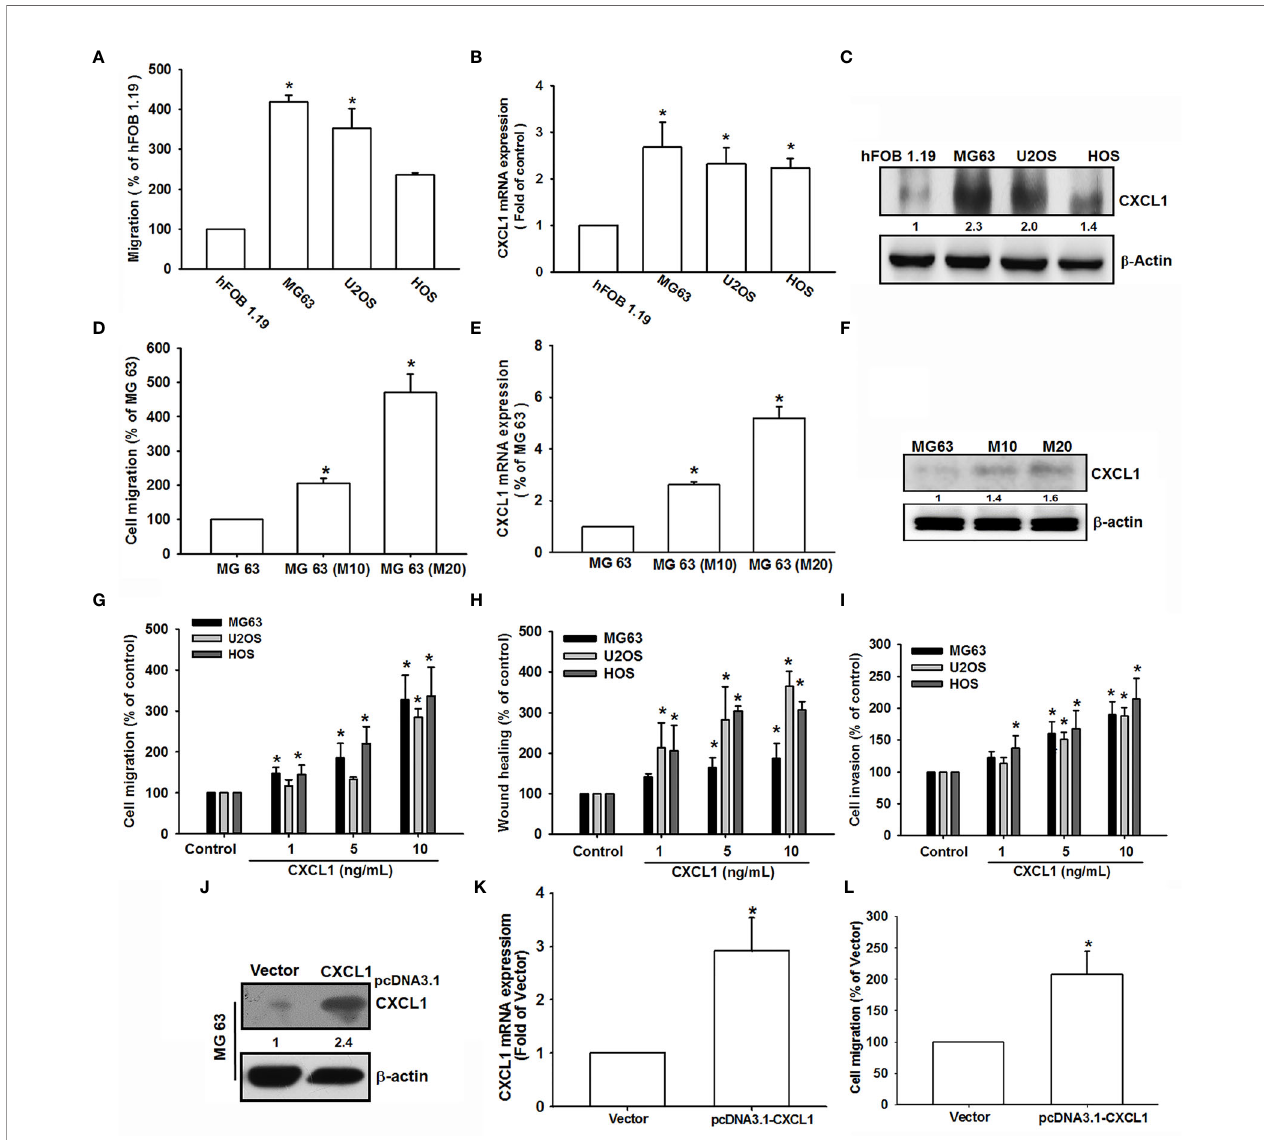
FIGURE 1 | CXCL1 increased migration, invasion, and wound healing in human osteosarcoma MG63, U2OS, and HOS cells. (A) The cell migration ability of the osteoblast cell line hFOB 1.19 and the osteosarcoma cell lines MG63, U2OS, and HOS was assessed using the Transwell assay. (B, C) Total mRNA and protein were collected from the indicated cell lines, and CXCL1 expression was detected using qPCR and Western blotting. (D – F) Migratory ability and CXCL1 expression of the indicated cells (MG63, M10, and M20) were examined by Transwell, qPCR, and immunoblotting assays. (G – I) Cells were incubated with CXCL1 (1 – 10 ng/ml) and the Transwell assay were used for detecting in vitro migratory, wound healing, and invasive activities after 18 h. (J – L) Cells were transfected with pcDNA3.1- conjugated CXCL1 plasmid and then CXCL1 mRNA, protein expression, and migratory potential were measured by immunoblotting, qPCR, and Transwell assays. Results were expressed as mean ± S.D. from at least three individual experiments. * p < 0.05 compared with the control group of each